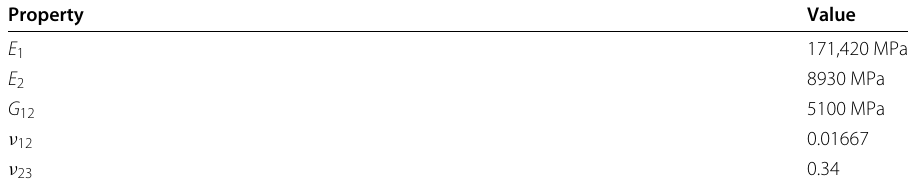
Table 4 IM7-8552 elastic properties used by the model